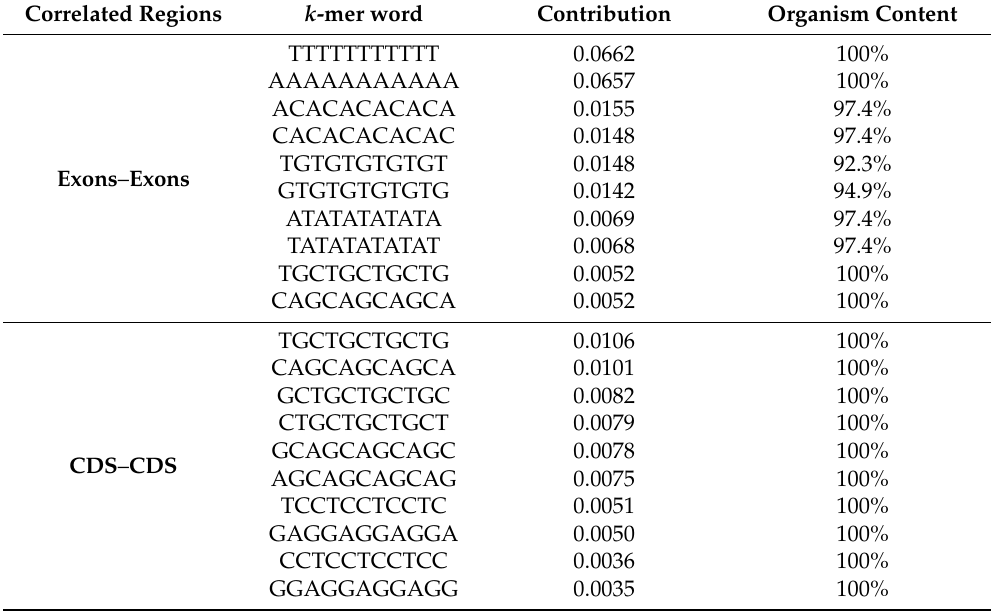
Table 4. List of 10 k -mer words with highest contribution to correlation values for k = 11. Organism Content, shown for homogenous pairings of sequence regions, is defined by the fraction of analyzed organisms for which the difference between content of the corresponding k -mer word and the mean k -mer word content (4 − k ) is larger than 1 σ , with respect to the k -mer word content distribution of the respective